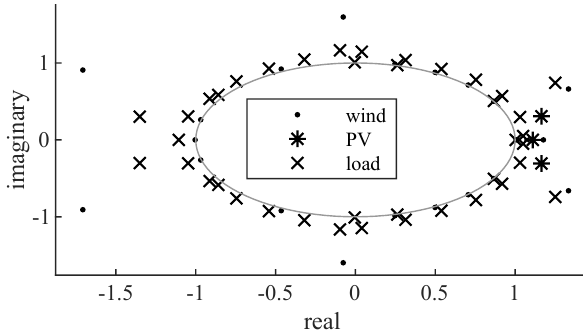
Figure A1. Roots of the characteristic polynomial of AR-processes lie outside the unit circle and are therefore stable according to [84].